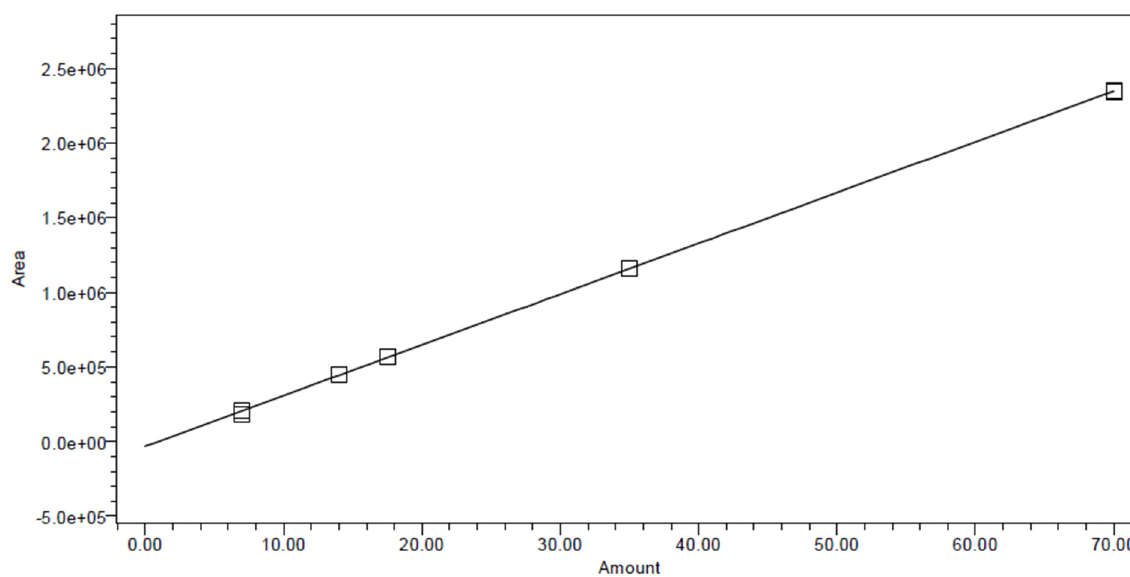
Figure 6. Calibration curve of PCM.